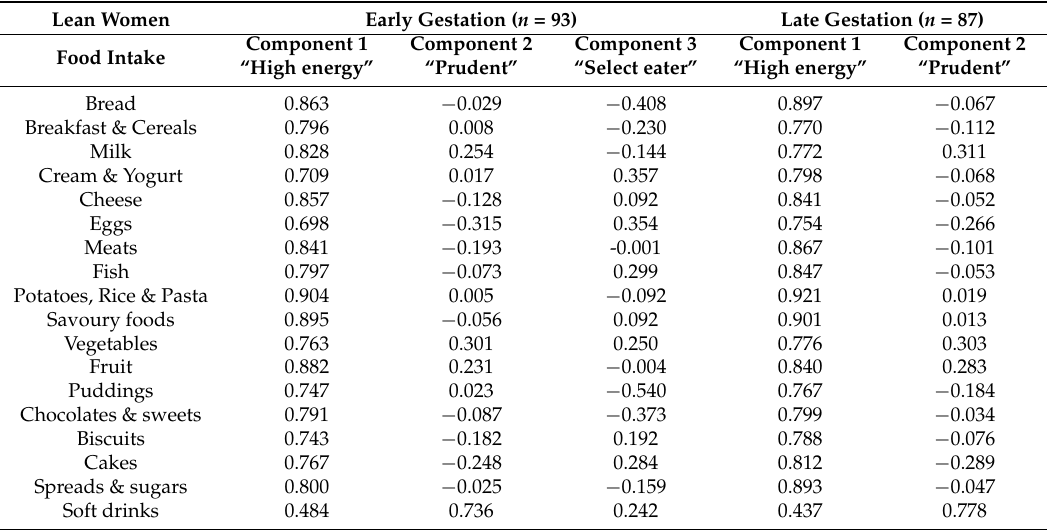
Table 7. Patterns of food intake in lean women in early and late